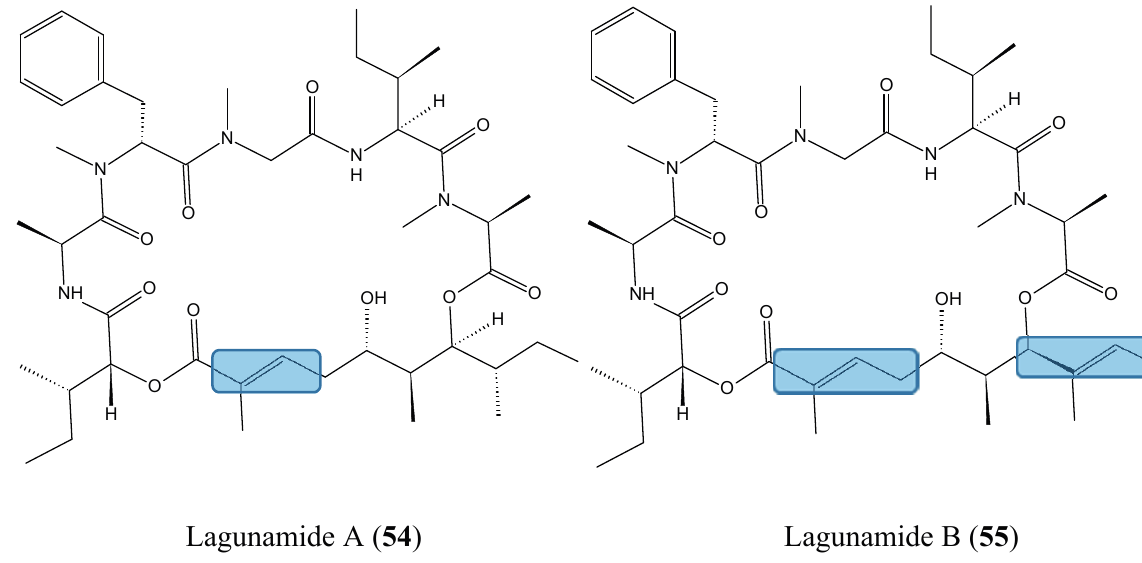
Figure 19. Lagunamide A and